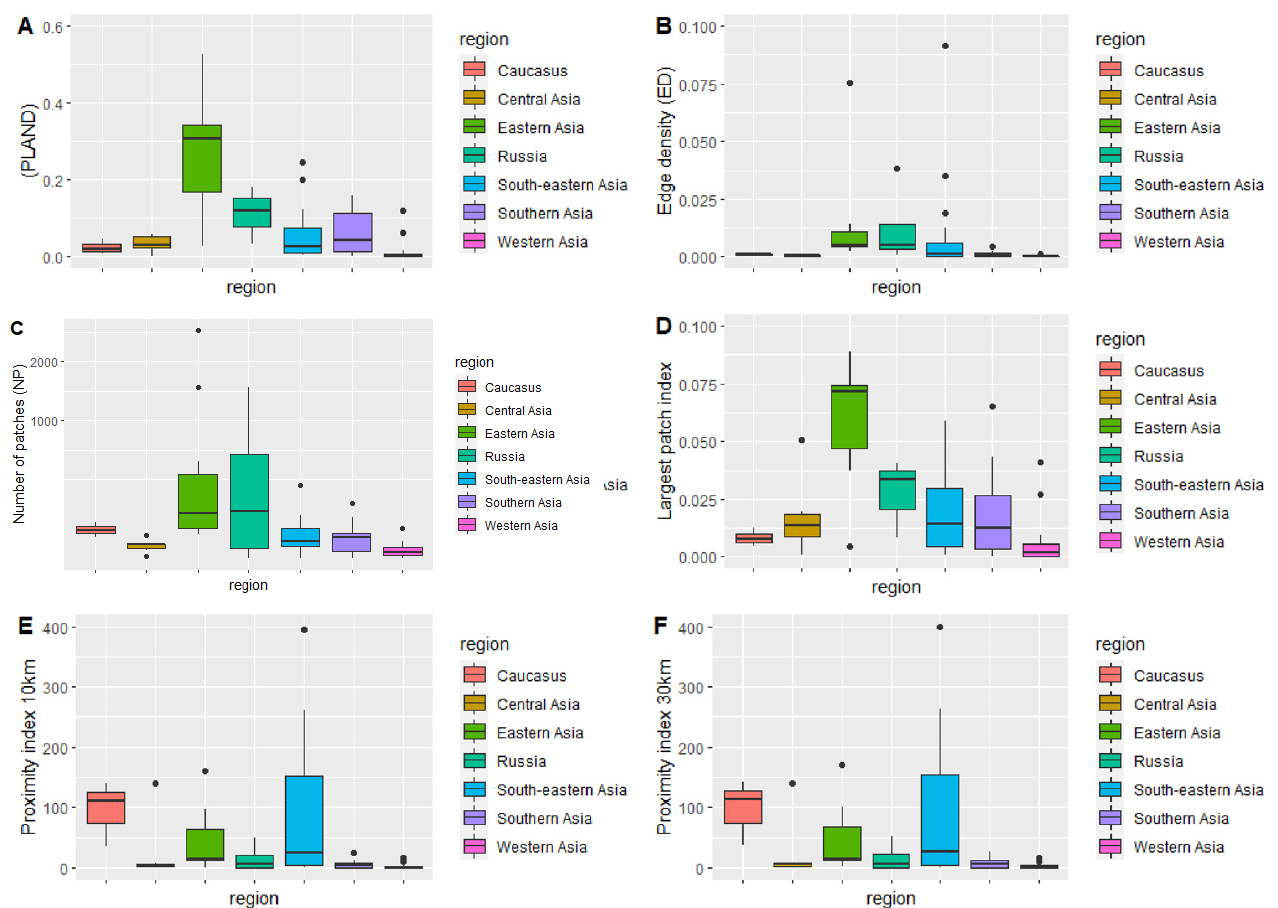
Figure 4. Regional analysis of different landscape metrics. ( A ) Percentage of landscape (PLAND); ( B ) Edge Density (ED); ( C ) Number of Patches (NP); ( D ) largest patch index (LPI); ( E ) Proximity index (PROX) at a 10 km radius; ( F ) PROX at a 30 km radius. Eastern Asia showed the highest NP in the region (mean: 530.3, p < 0.05), significantly different to Central, Southeastern, Southern, and Western Asia (Figure 4C). ED in Eastern Asia (mean: 0.035, m/ha, p < 0.05) was higher than ED in Caucasus, Central, Southern, and Western Asia. Russian ED (mean 0.01 m/ha, p < 0.05) also was significantly higher than in Southern Asia (Figure 4B). Eastern Asia exhibited a significant higher LPI (mean: 0.26%, p < 0.05) than Central, Southern, and Western Asia (Figure